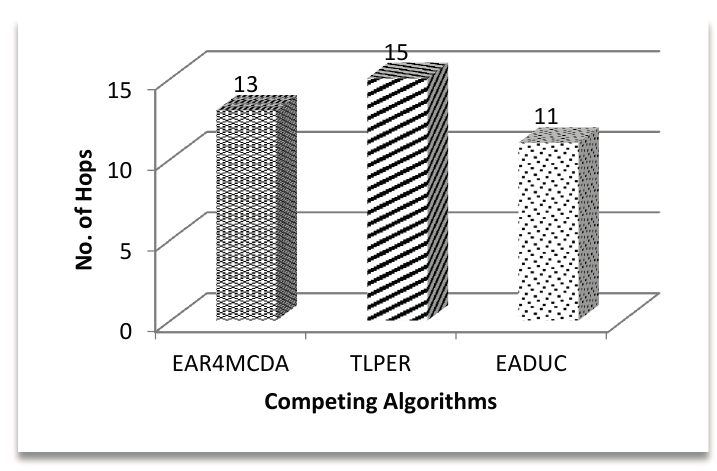
Figure 10. No. of designed clusters.